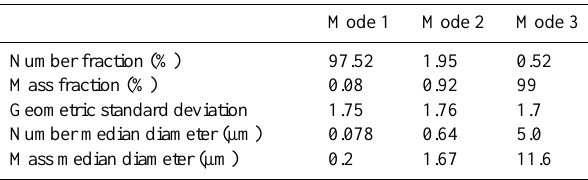
Table 1. Log-normal parameters of the AMMA size distribution used in DEAD coupled with